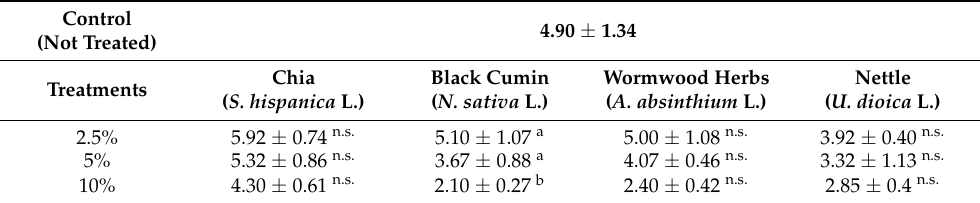
Table 12. Comparison of differences of means for radicle length of spinach ( S. oleracea L.) seedlings (The values in the table represent the mean value of radicle length in cm ± SD).